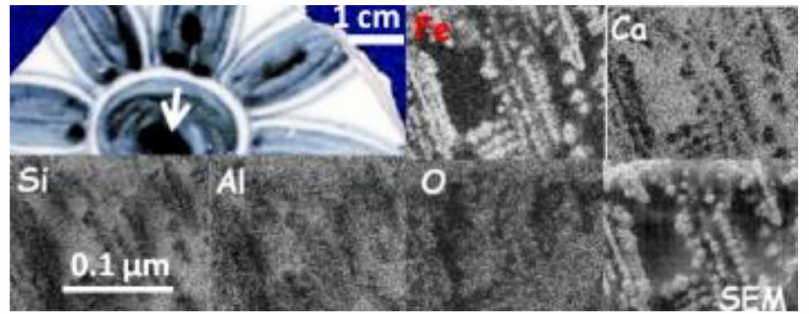
Figure 12. Examples of dendrites observed on black spots similar with those observed on the Vietnamese sherd (Chu Dau kiln, 15th-Century). Dendrites are iron rich and are depleted in Si, Al, and Ca elements. See more details in